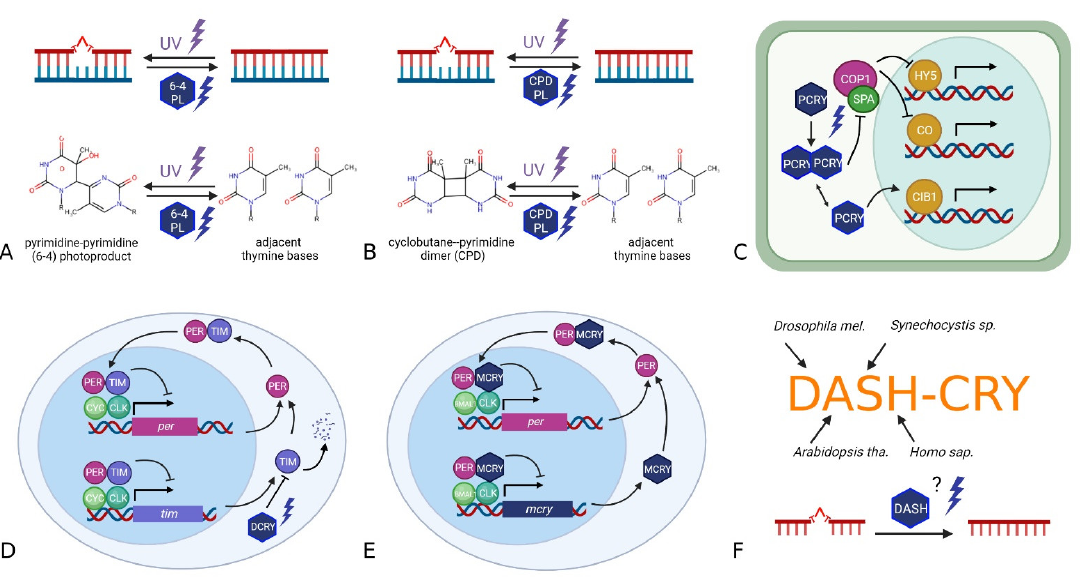
Figure 1. Schematic overview of six main members of the CRY/PL family based on their function in major model organisms and references given in the introduction. ( A , B ) The photosensitive photolyases repair UV-induced pyrimidine-pyrimidone dimer mutations in DNA using blue light. Depending on the type of mutation they repair, they are called 6-4 photolyases (pyrimidine-pyrimidone-6-4 photoproduct) or CPD photolyases (cyclobutane-pyrimidine dimer). Plant PCRYs ( C ) are photosensitive and directly or indirectly affect the transcription of several genes whose functions are also linked to the circadian clock. The Drosophila light-sensitive cryptochrome (DCRY) is activated by blue light and destabilizes TIMELESS, resulting in a resetting of the circadian clock ( D ). The mammalian light insensitive MCRY, which is also involved in the circadian clock, acts as an indirect transcription factor, and inhibits its own expression ( E ). DASH-CRYs ( F ) act as a link between different members of the CRY/PL family. They appear to be involved in both the circadian clock and the repair of mutations in single-stranded DNA.